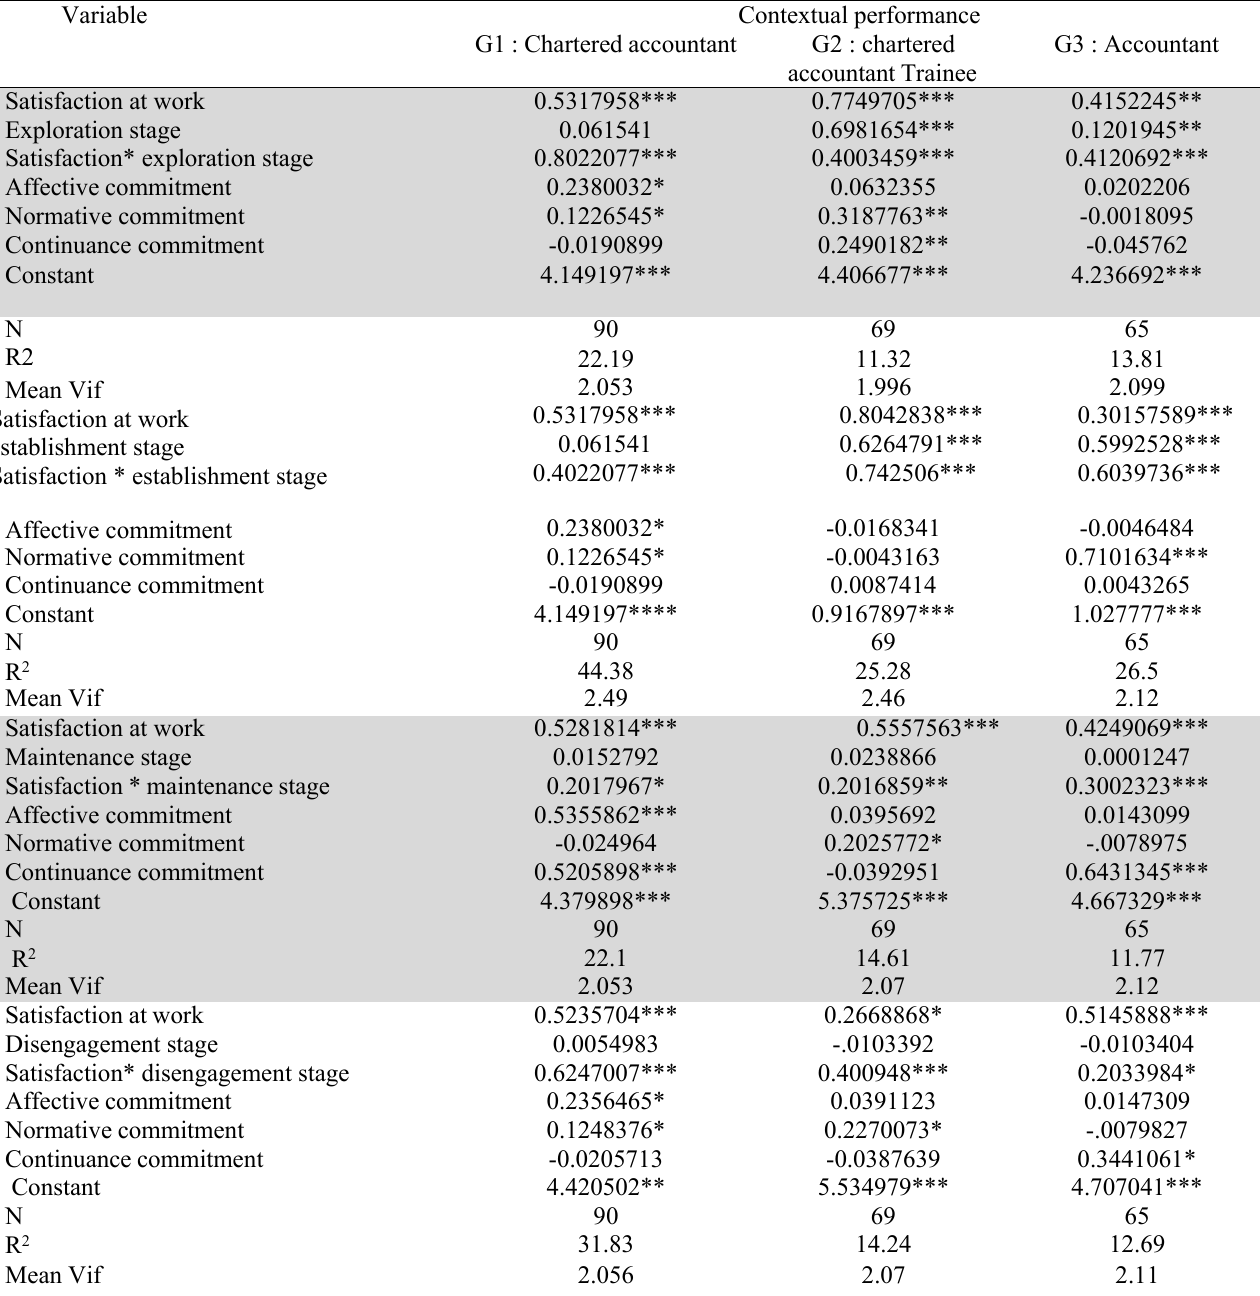
Results of the structural model using TSLS with bootstrap (95% CI) Dependent variable: Contextual